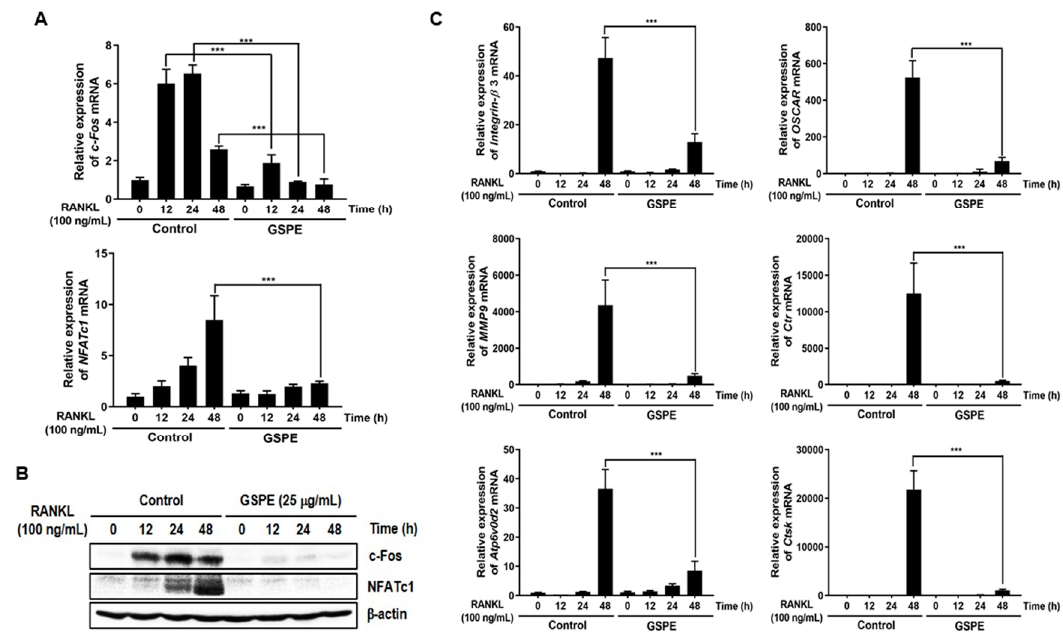
Figure 3. GSPE downregulates RANKL-induced c-Fos, NFATc1, and osteoclastogenic-specific marker genes. BMMs were stimulated with 30 ng / mL M-CSF and 100 ng / mL RANKL in the presence or absence of 25 µ g / mL GSPE for the indicated time periods. ( A ) mRNA expression levels of the c-Fos and NFATC1 genes were evaluated using real-time RT-PCR. ( B ) The protein expression levels of c-Fos and NFATc1 were evaluated using Western blot analysis. ( C ) The expression levels of Integrin- β 3 , OSCAR , MMP9 , Ctr , Atp6v0d2 , and CtsK mRNA were analyzed using real-time RT-PCR. *** p < 0.001 versus control. Abbreviations: GSPE, grape seed proanthocyanidin extract; RANKL, receptor activator of nuclear factor kappa- Β ligand.